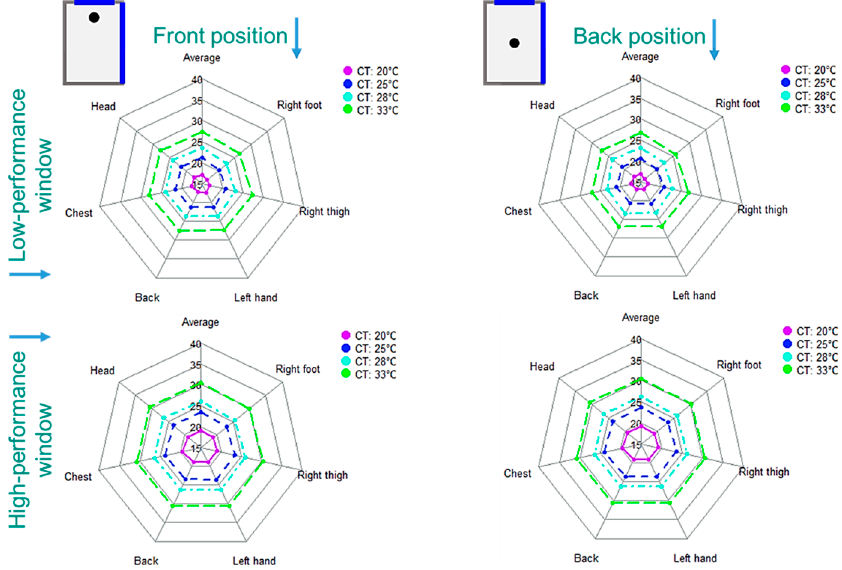
Figure 13. Air temperatures at selected body limbs in the corner room with two facades influenced by the ceiling temperatures, quality of facades, and the position of the manikin.